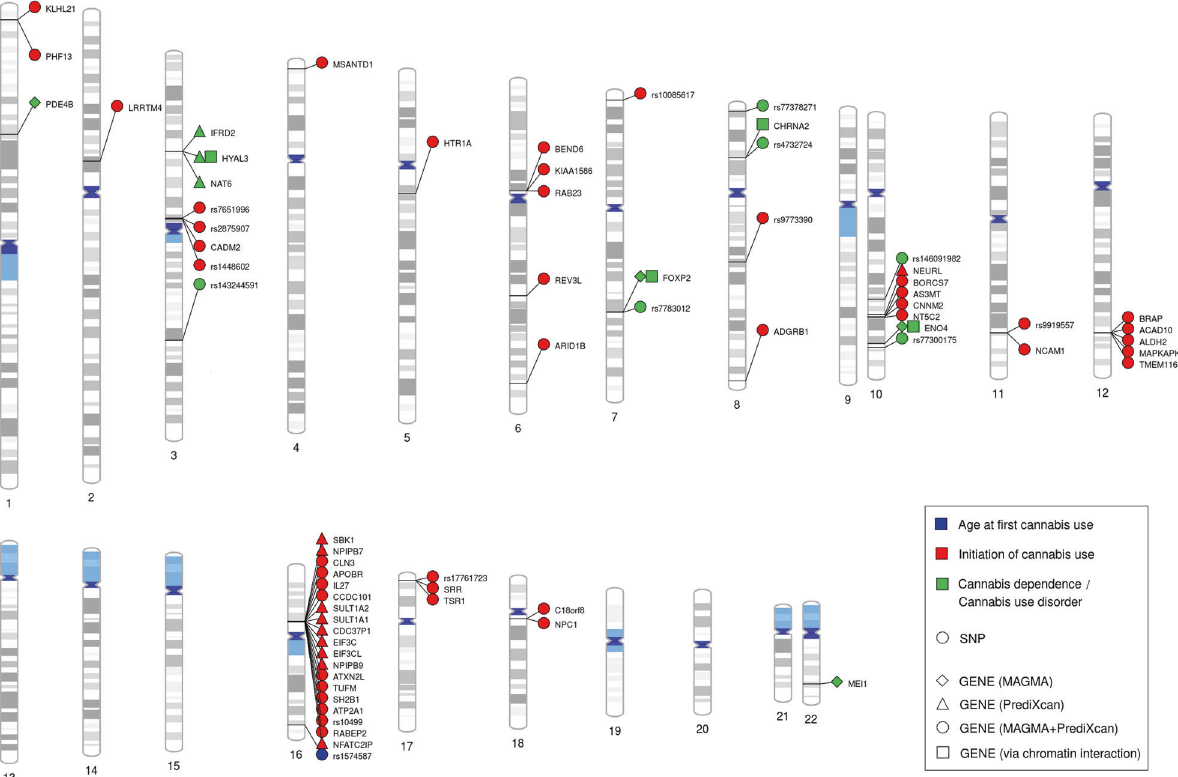
Fig. 1 Genomic locations of the identi fi ed genome-wide signi fi cant SNPs and genes. Illustration of the genomic locations of the genome- wide signi fi cant SNPs and genes for cannabis use phenotypes as identi fi ed in genome-wide association